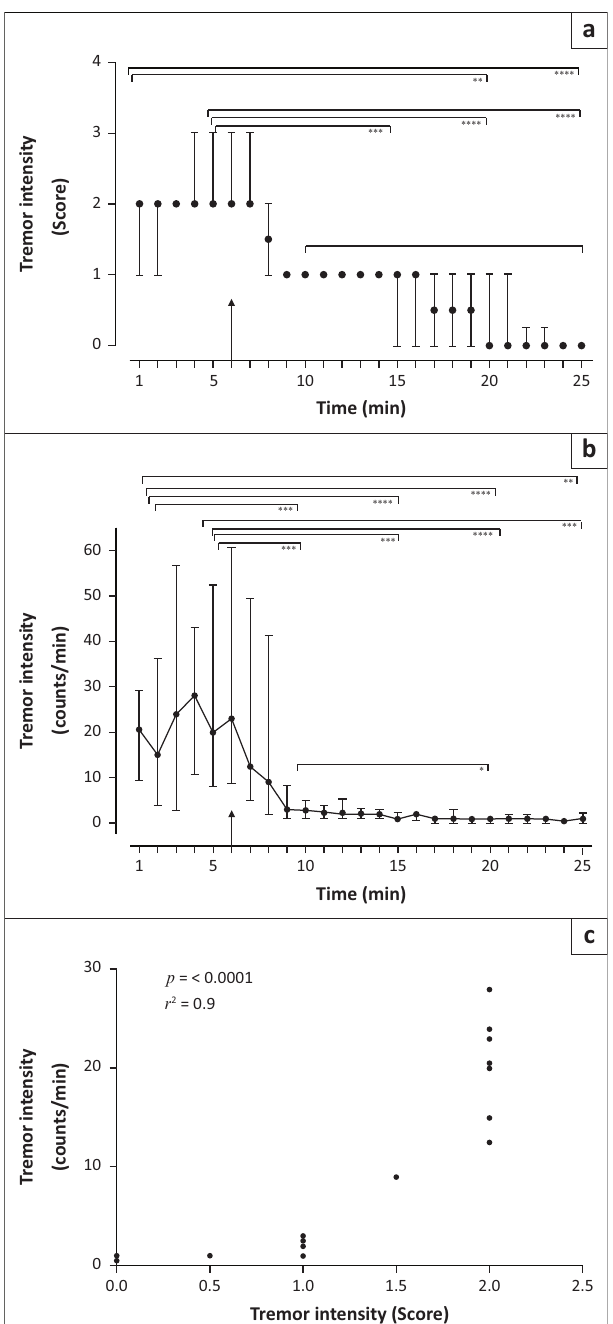
FIGURE 1: Median observed tremor intensity scores (a) and the median activity logger counts per minute (b), with interquartile ranges, of 14 free-ranging white rhinoceros that were chemically immobilised with a mixture of etorphine and azaperone. The arrow represents the time point at which butorphanol (IV) was administered and nasotracheal oxygen insufflation initiated. The brackets indicate which time intervals are significantly different from the other ( * , p < 0.05; ** , p < 0.01; *** , p < 0.001; **** , p < 0.0001; Friedman’s test with post-hoc Dunn’s tests for tremor intensity scores; ANOVA with post-hoc Tukey’s test on log-transformed tremor intensity counts; the data, however, are shown as actual counts). (c) Median tremor intensity (counts/min), which was recorded by the activity loggers, was compared to median tremor intensity (score), which was observed in the 14 white rhinoceros (Spearman rank-order